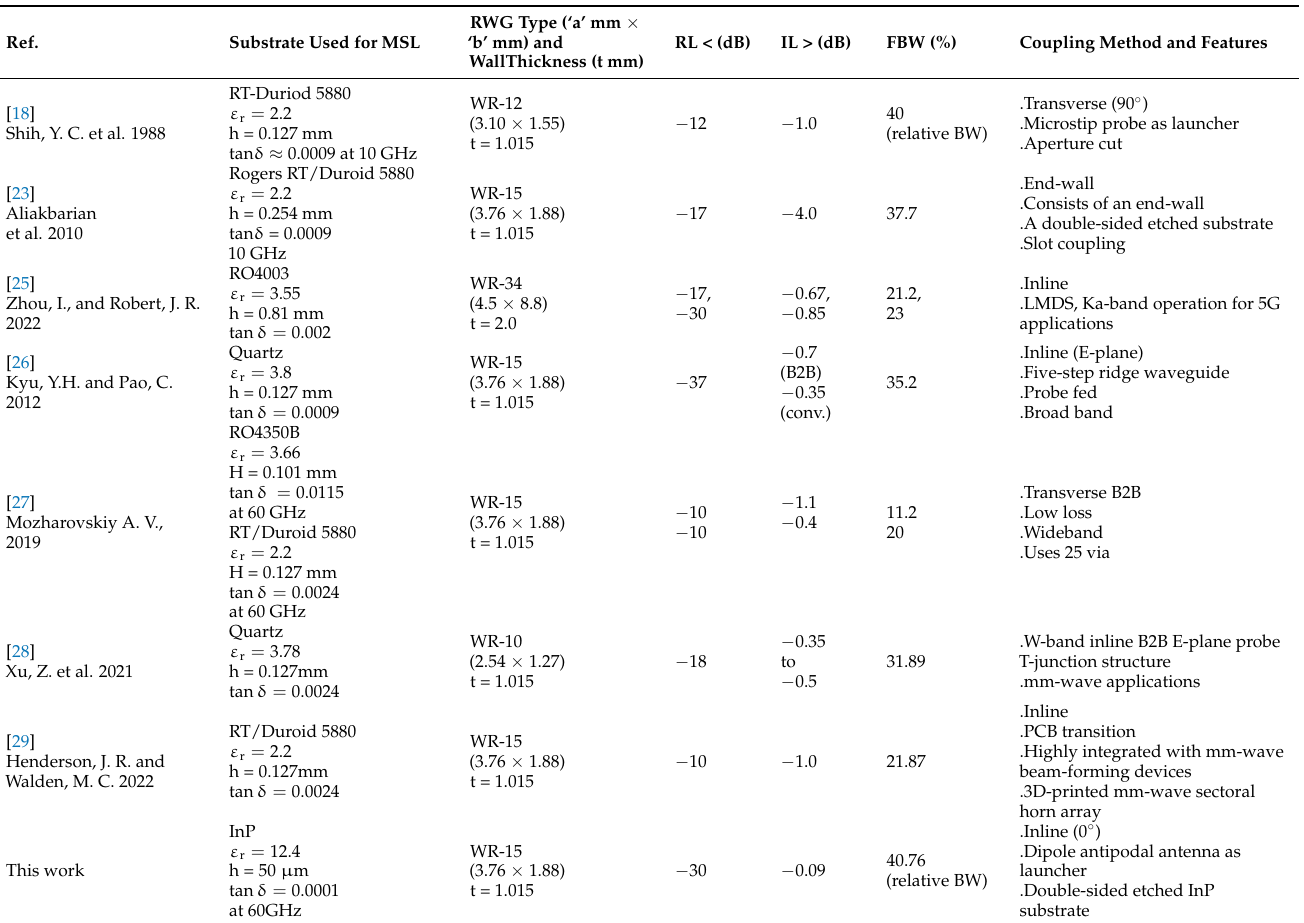
Table 6. Performance comparison of proposed V-band (50 GHz–75 GHz) transitions with the existing